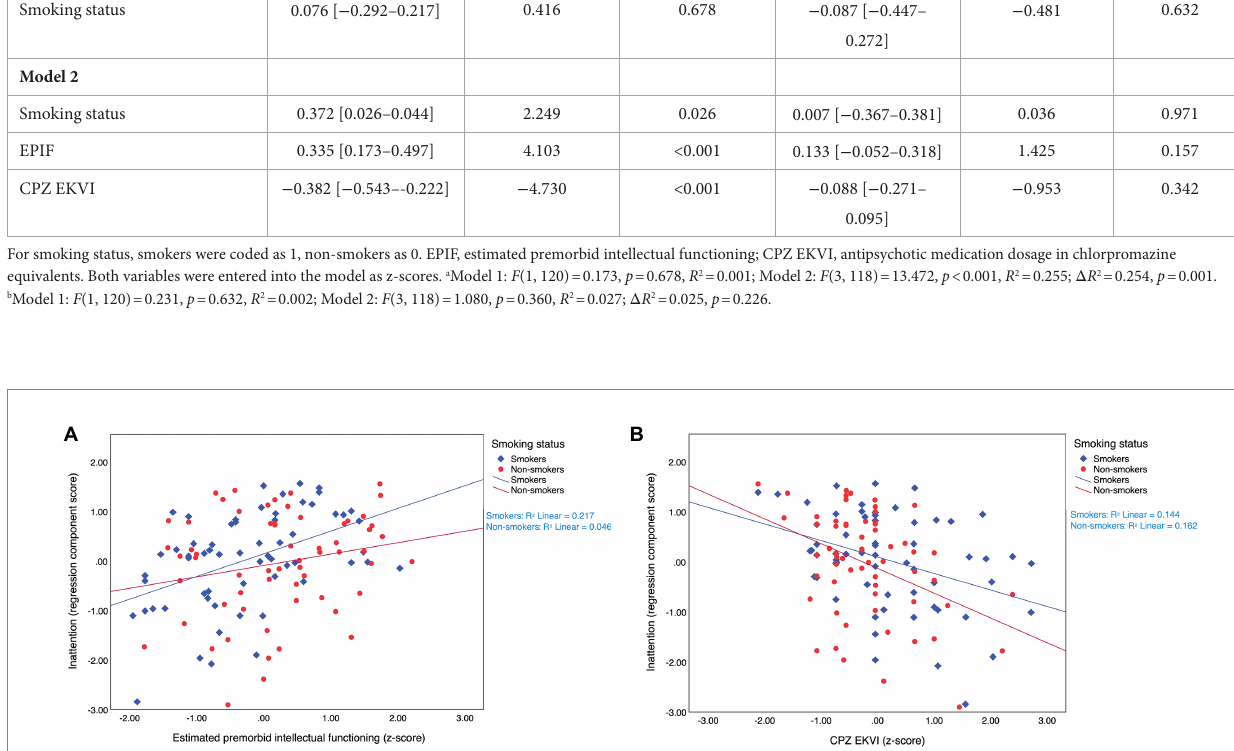
observed, but the effect of the cigarette smoking extent remained non-significant (Table 4).